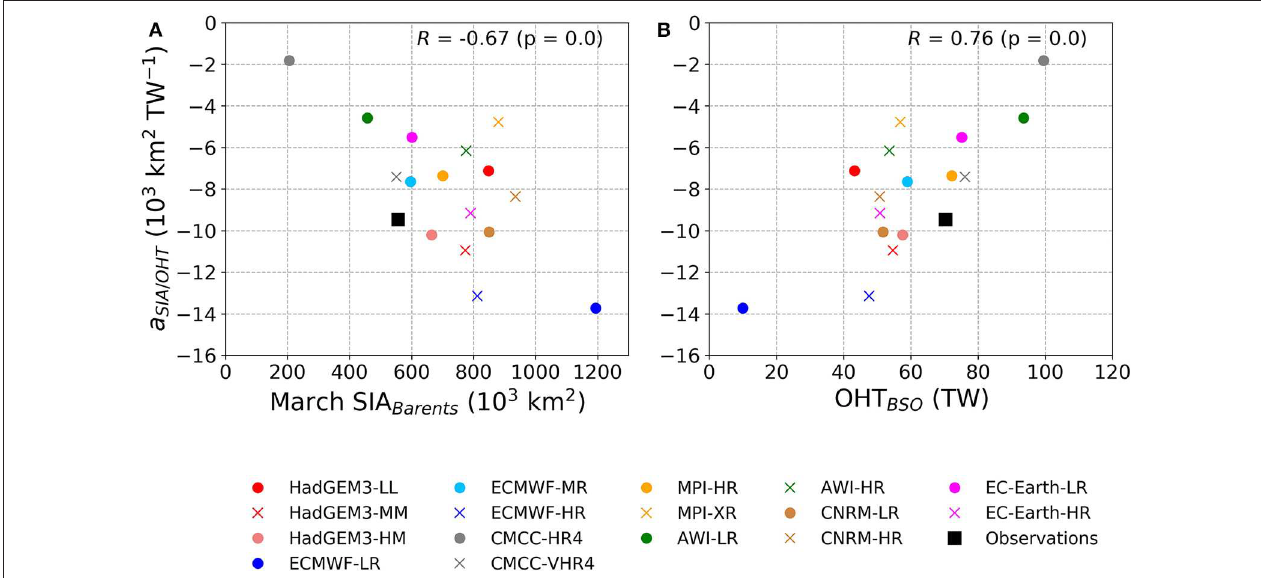
FIGURE 11 | Scatter plots of regression slopes ( a SIA / OHT ) between detrended March Barents sea-ice area (SIA Barents ) and detrended annual mean ocean heat transport (OHT) at the Barents Sea Opening (BSO, large transect; OHT leads SIA by 1 year) against (A) mean March Barents sea-ice area, and (B) annual mean OHT at the Barents Sea Opening (large transect) for all HighResMIP hist-1950 model outputs (averaged over 1950–2014) and observations/reanalysis. Correlation coefficients R (with their p -value) are indicated in the upper right corner of each